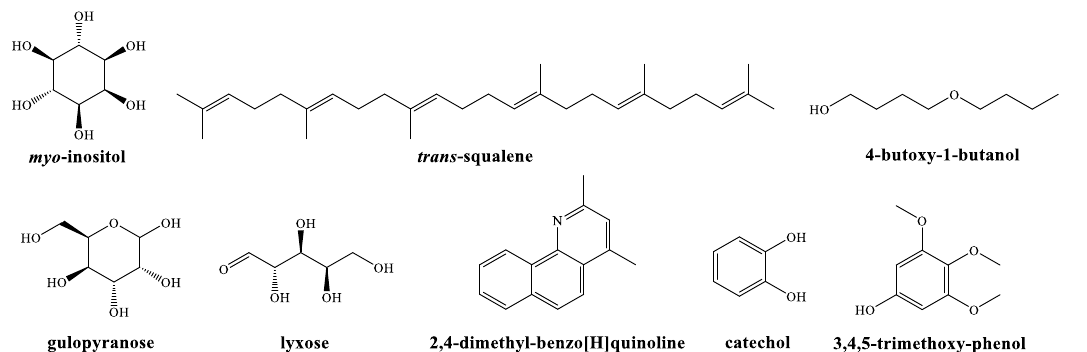
Figure 1. Main phytochemicals identified in the aqueous ammonia extract of Q. ilex subsp . ballota bark.